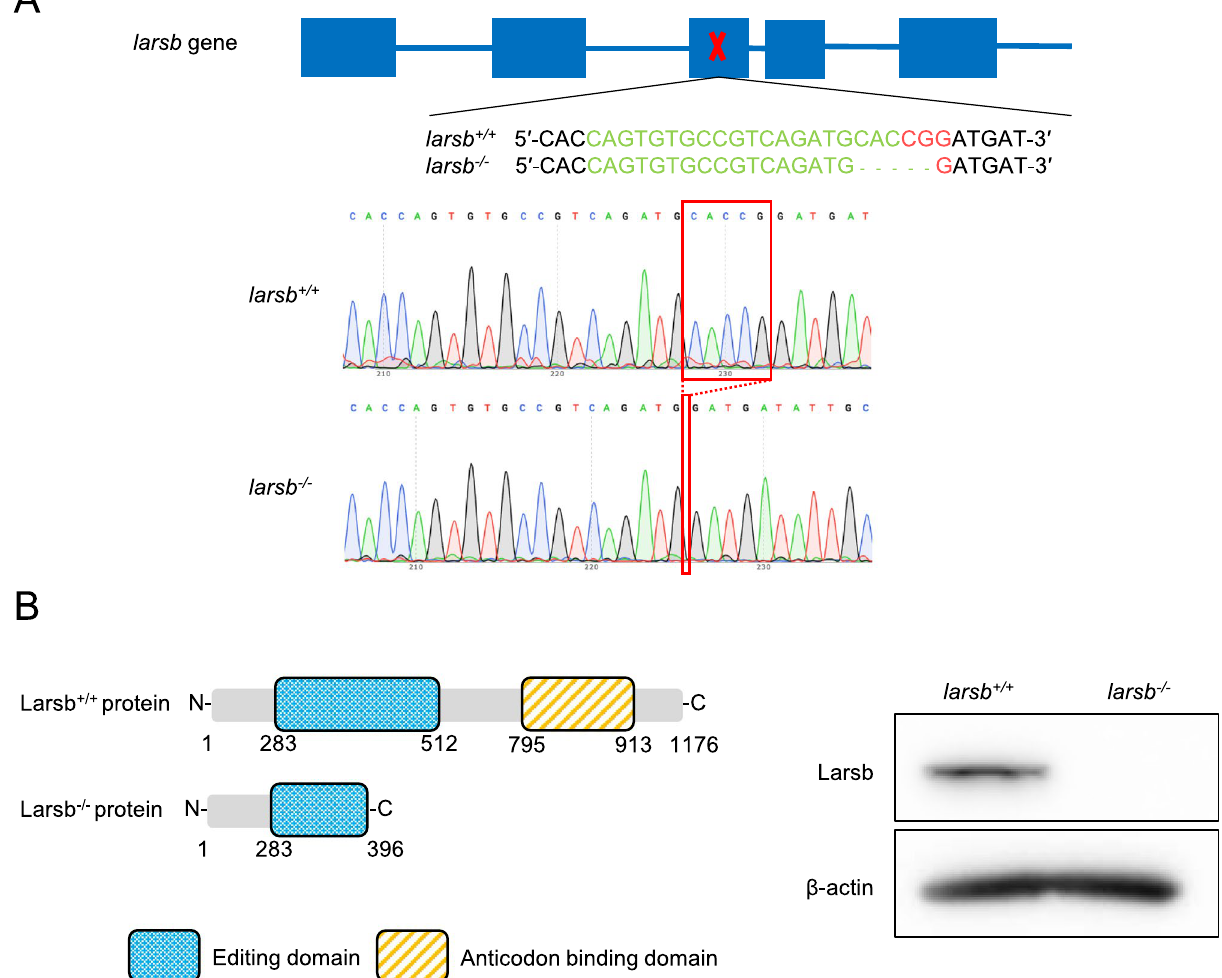
Figure 1. Construction of larsb -knockout mutant zebrafish line. (A) Diagram showing the larsb genomic locus, CRISPR/Cas9 target site, and larsb -knockout ( larsb −/− ) zebrafish mutant genotype. The sgRNA target sequence is displayed in green and the PAM region in red. In the genomic sequencing analysis chromatograms, the deletion region in the mutant larsb −/− zebrafish is shown by the red box. (B) The Lars protein of larsb −/− zebrafish had a missing editing domain. Western blot analysis of the Larsb protein expression in larsb + / + and larsb −/− zebrafish. β-actin levels served as the loading control. Larsb: leucyl-tRNA synthetase